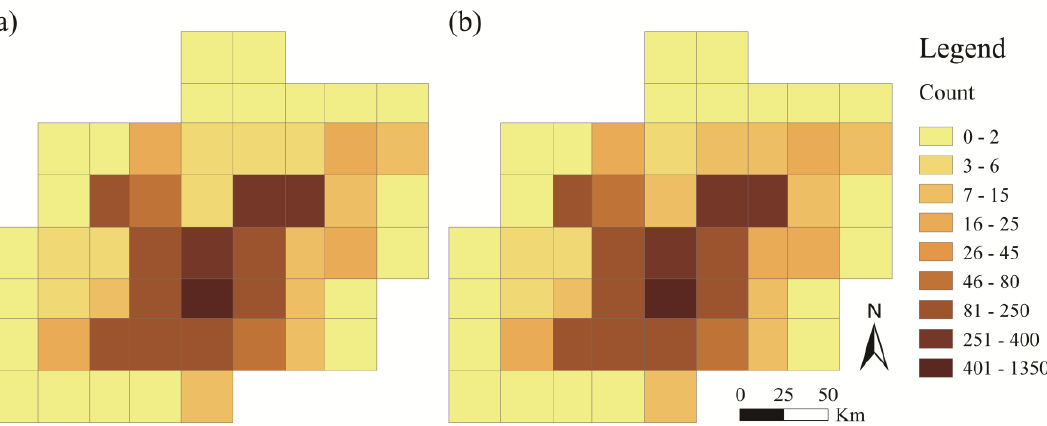
Figure 9. The heat map of POI distribution expressed by the 11th level grid of GeoSOT grid: ( a ) generated using real POI data; and ( b ) Generated using hexagonal grid data interpolation.